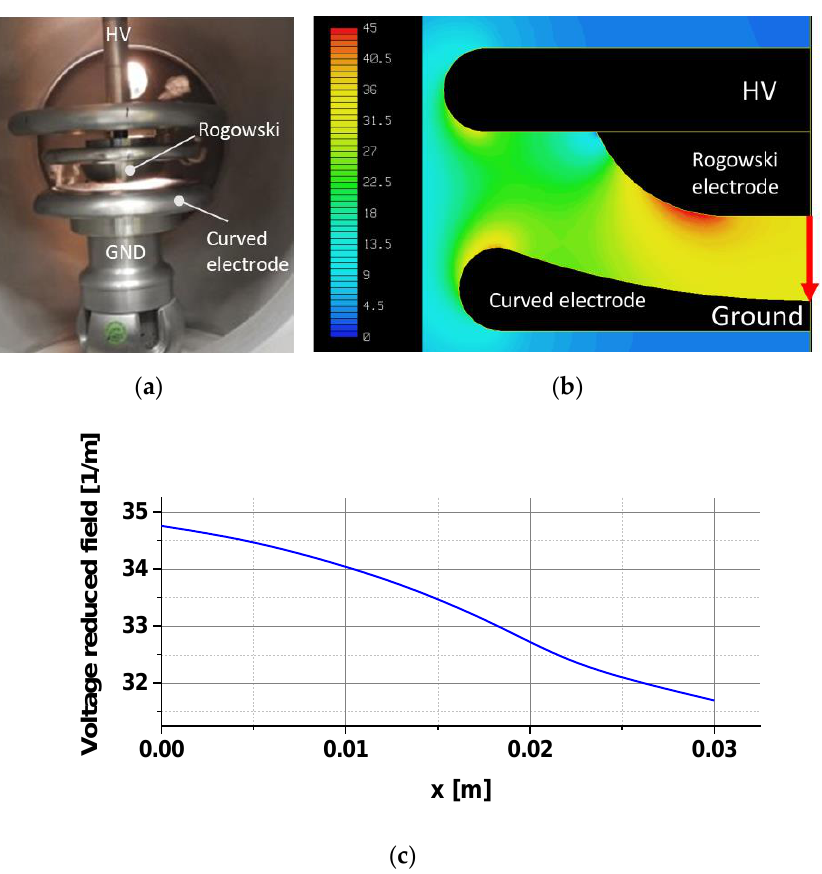
Figure 1. ( a ) Photograph of test set-up 1. High voltage and ground electrodes are indicated by HV and GND respectively. ( b ) Numerical simulation of the electric field distribution in set-up 1, the curved electrode vs. Rogowski electrode configuration with 30 mm gap. ( c ) Electric field strength decay along the axis of symmetry, indicated by the red arrow in ( b ).